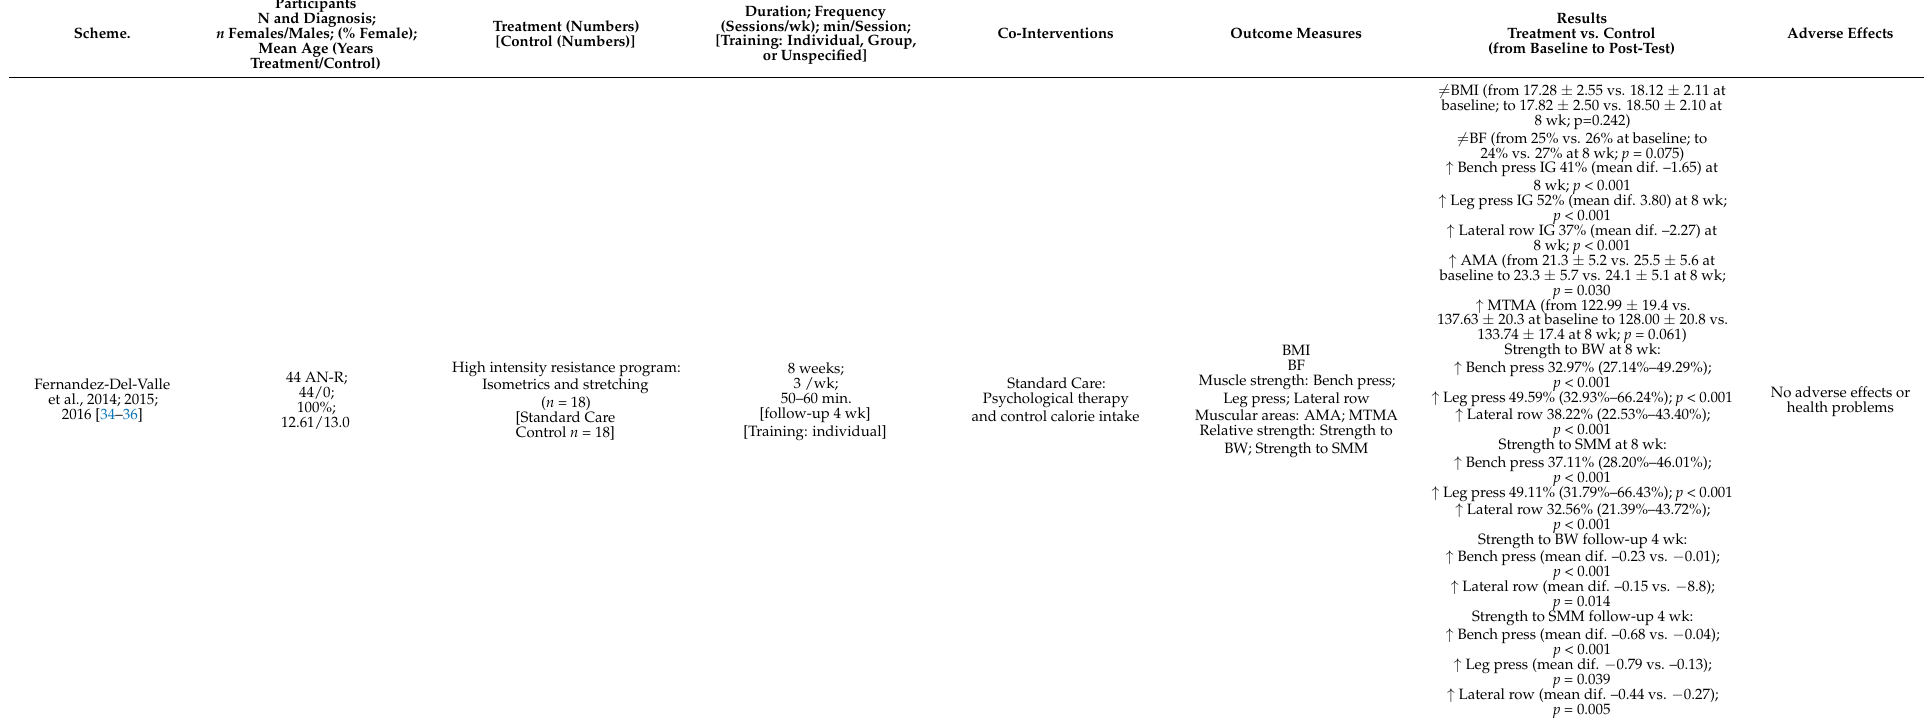
Participants NandDiagnosis; n Females/Males;(%Female); MeanAge(Years